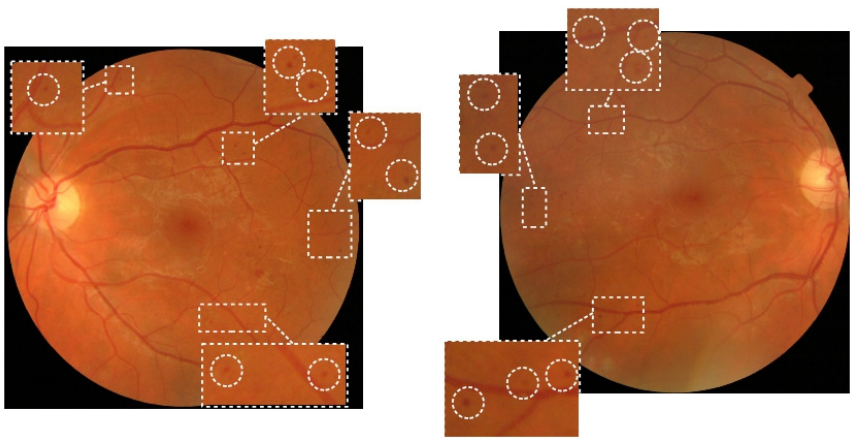
Figure 1. Examples of fundus images of the left and right eye with several